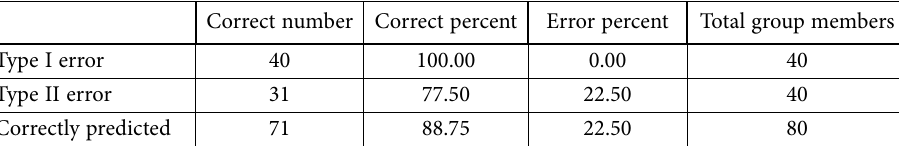
Table 6. Model prediction for two years prior to bankruptcy or insolvency (source: authors’ processing)